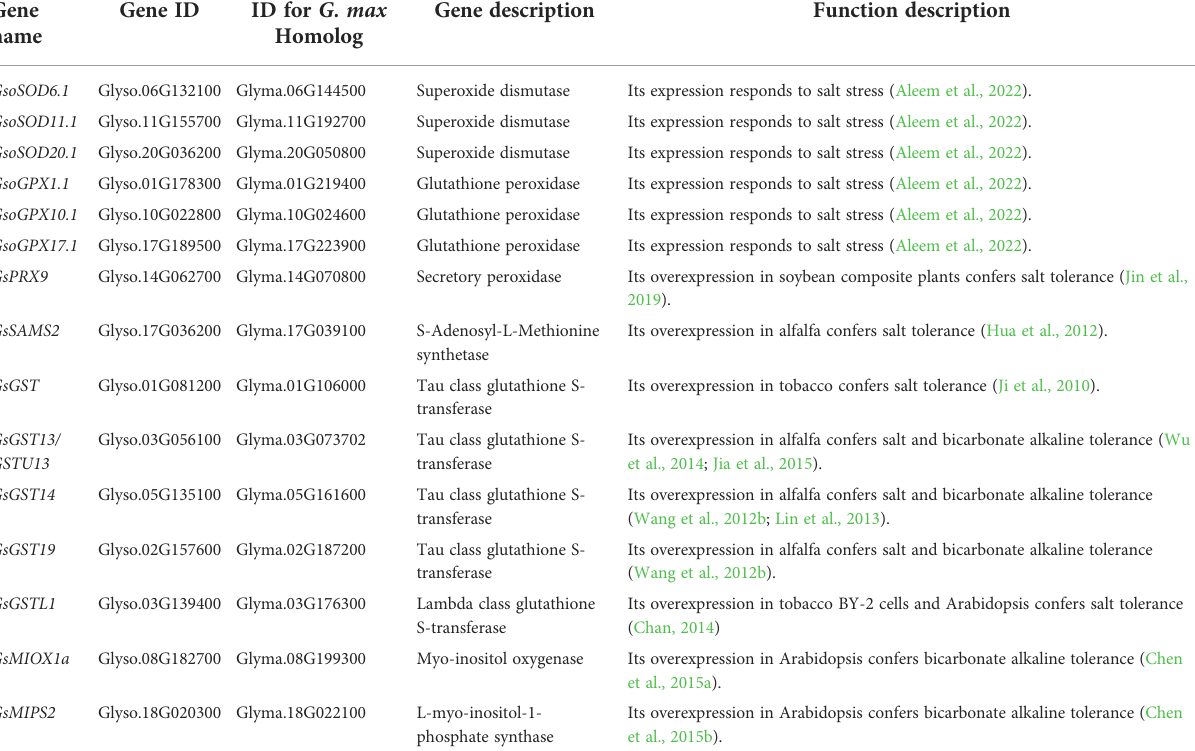
TABLE 2 Genes involved in ROS scavenging under salt-alkaline stress in wild